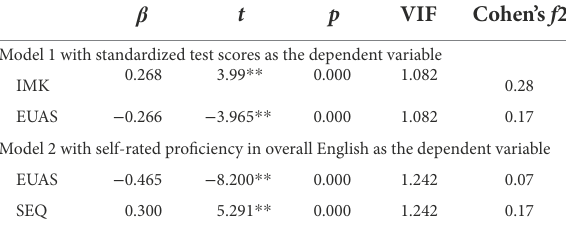
TABLE 4 Multiple regression coefficients and significance of predictors for English achievements.